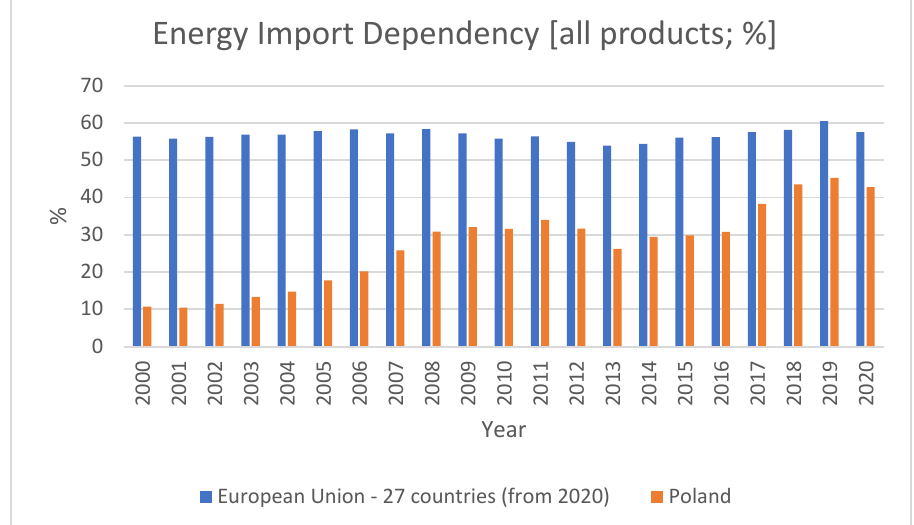
Figure 4. Energy import dependency (Poland vs. EU-27) over the period 2000 – 2020 (all products; %). Source: Own elaboration based on Eurostat data [23].